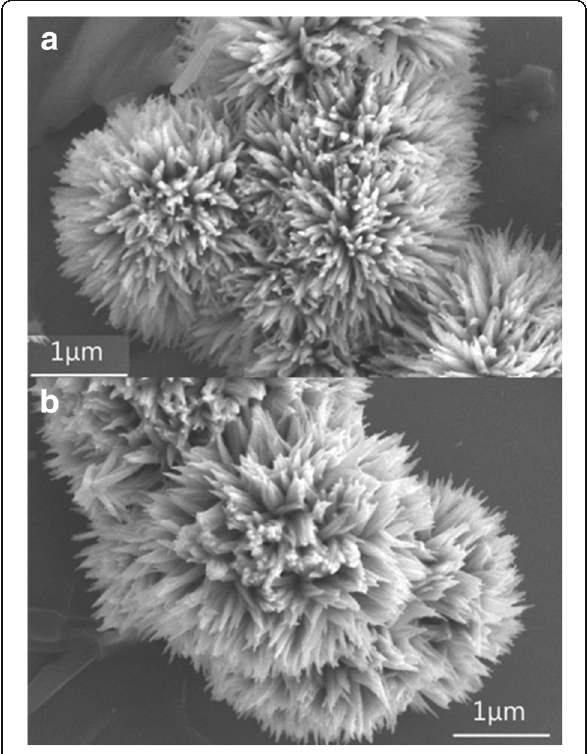
Fig. 2 a , b Typical FE-SEM images of the sea urchin-like precursor and NiCo 2 O 4 synthesized with 5 g PDDA